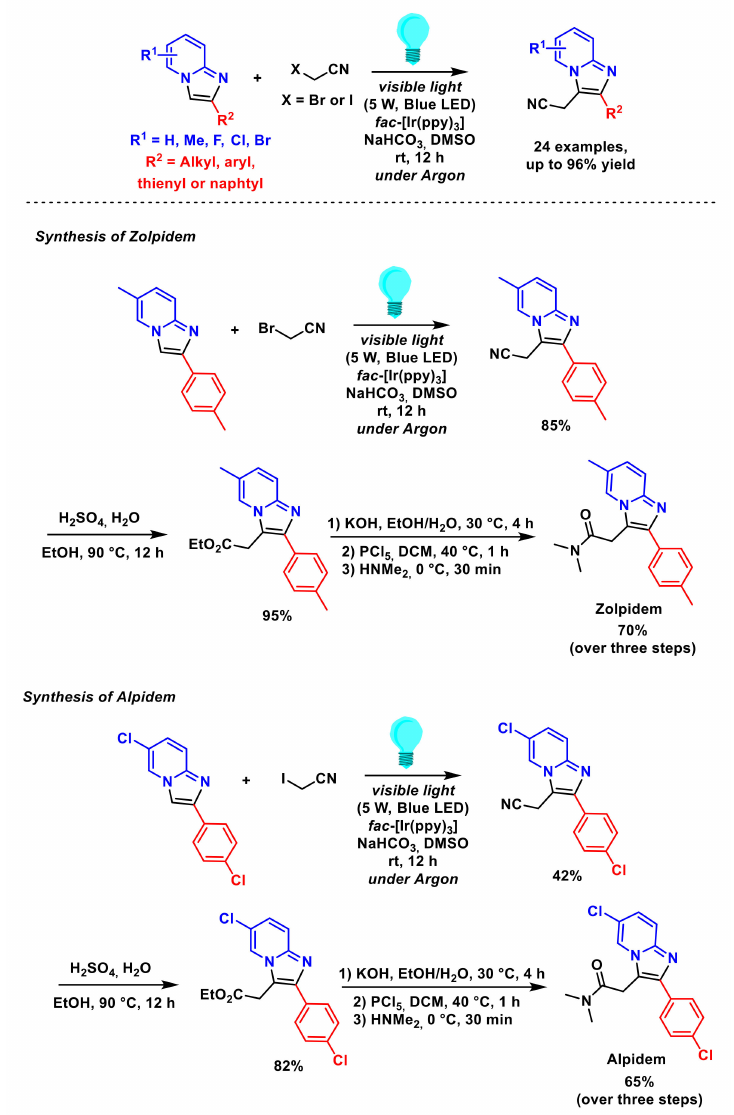
Aminoalkylation has also drawn attention in the topic of imidazopyridines’ func- tionalization. In 2018, Hajra and co-workers disclosed the metal-free coupling between tertiary amines and imidazo[1,2- a ]pyridines [49]. With rose bengal as the organocatalyst under aerobic conditions, they combined N -phenyltetrahydroisoquinoline with imida- zopyridines in a regioselective manner (Scheme 14). A broad range of highly substituted imidazopyridines was thus produced. Good to excellent yields were obtained with electron- donating or -withdrawing groups. The approach was also extended to N , N -dimethylaniline derivatives with success. Control experiments implemented the elucidation of the mech- anism with radical scavengers (TEMPO, BHT) and a singlet oxygen quencher (DABCO: 1,4-diazabicyclo[2.2.2]octane). The suggested pathway could pass through an energy trans- fer between the excited state of the photocatalyst (RB*) and the ground-state oxygen ( 3 O 2 ). The generated singlet oxygen could undergo an SET for the tertiary amine to deliver the amine radical cation. By hydrogen capture, an iminium is then formed. This latter molecule could be implied in an electrophilic addition with the imidazopyridine. A final proton abstraction could then give the target